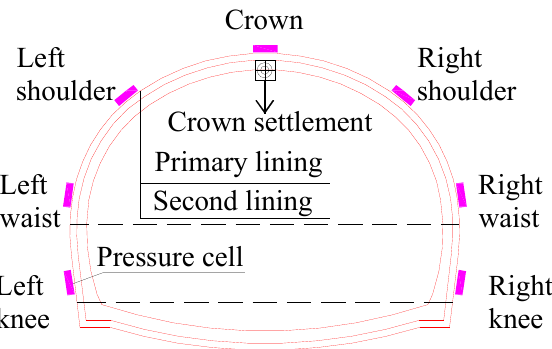
Figure 3. Layout of monitoring points for each tunnel (monitoring instruments at the knees were installed later).